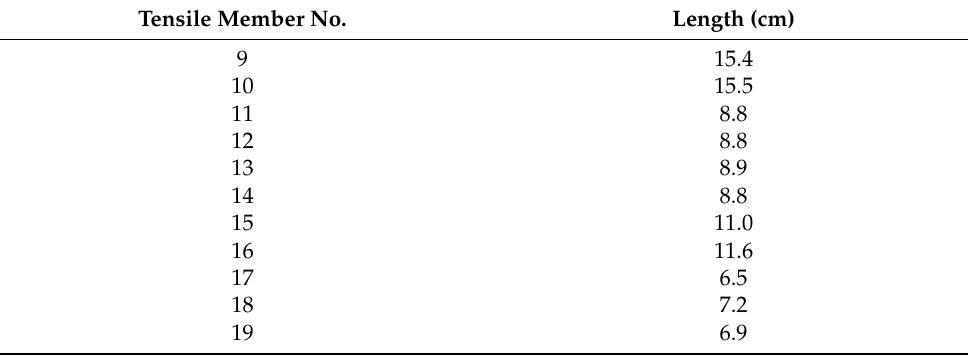
Table 4. The lengths of tensile members for strings for members No. 9 to No. 19. Tensile Member